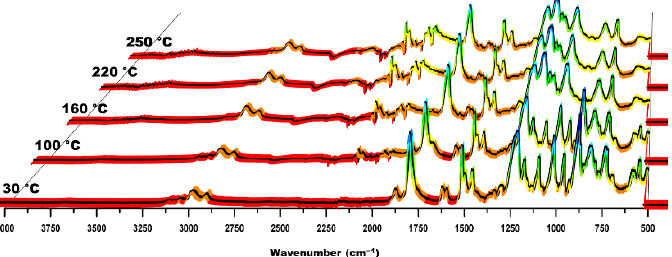
Figure 3. FTIR spectra registered during heating the T-HHPA formulation. Temperatures are indi- cated on each spectrum.